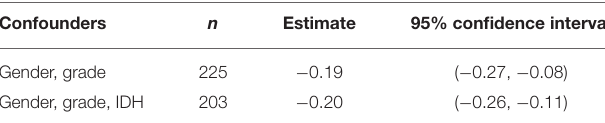
TABLE 1 | Latent causal effects and associated confidence intervals in glioblastoma